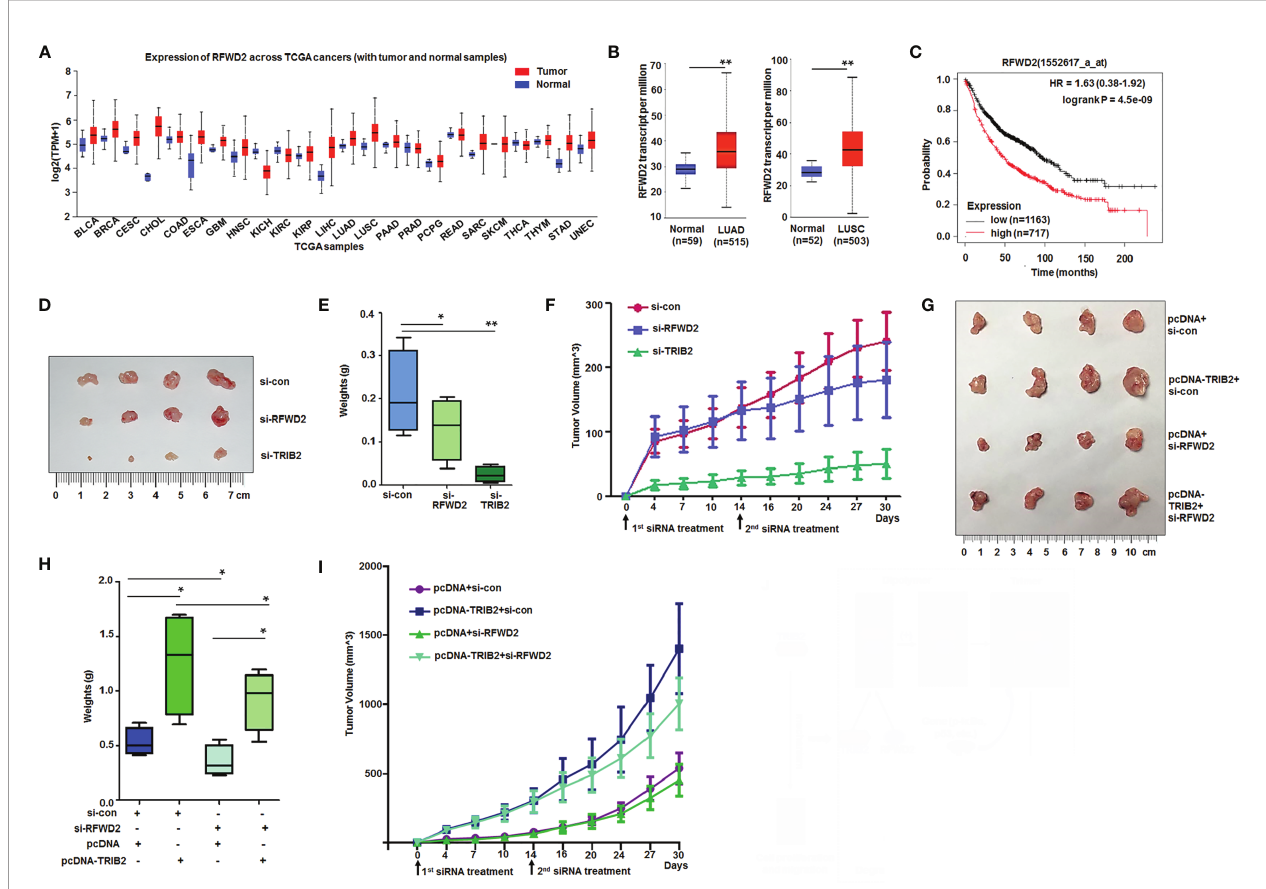
FIGURE 7 | High levels of RFWD2 in cancer and RFWD2 inhibition blocking functions of TRIB2 in vivo. (A) RFWD2 is obviously higher in the tissues of various kinds of tumors. (B) RFWD2 is overexpressed in lung adenocarcinoma and lung squamous cell carcinoma tissues. (C) Kaplan-Meier plot analysis of the relationship between RFWD2 levels and clinical outcome. (D) Suppressive role of TRIB2-siRNA and RFWD2-siRNA on A549 cell xenografts in BALB/C-nude mice. (E) The xenografts of each group ( n = 4) were weighed, and data were expressed as median (interquartile range). * p < 0.05, ** p < 0.01. (F) Volumes of xenografts from each group measured over time. (G) Effect of RFWD2 downregulation in xenografts of A549 cells stably overexpressing TRIB2. (H) Xenografts from each group ( n = 4) were weighed, and data were expressed as median (interquartile range). ** p < 0.05. (I) Volumes of xenografts from each group measured over